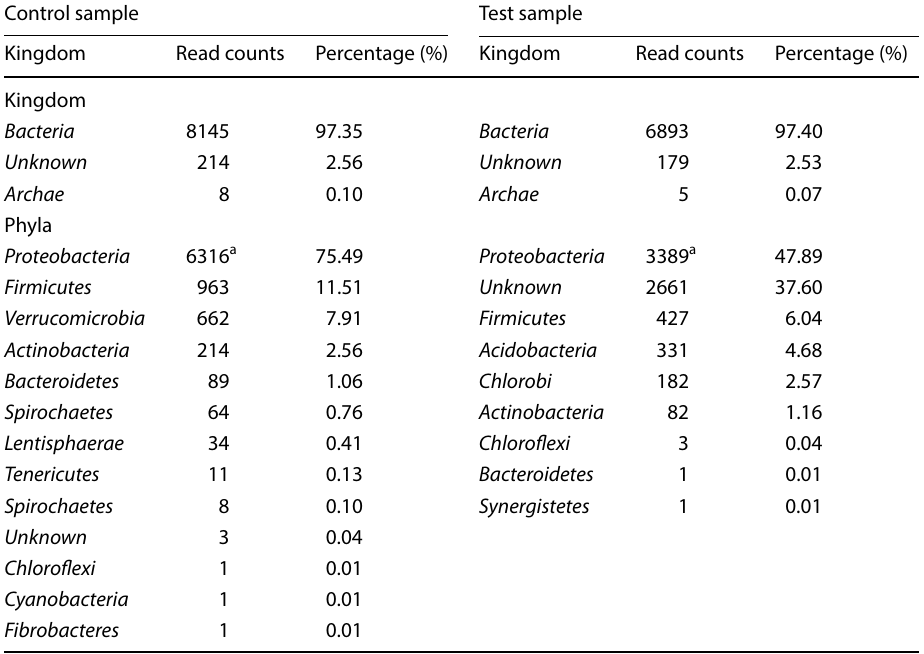
Table 4 Kingdom and phyla